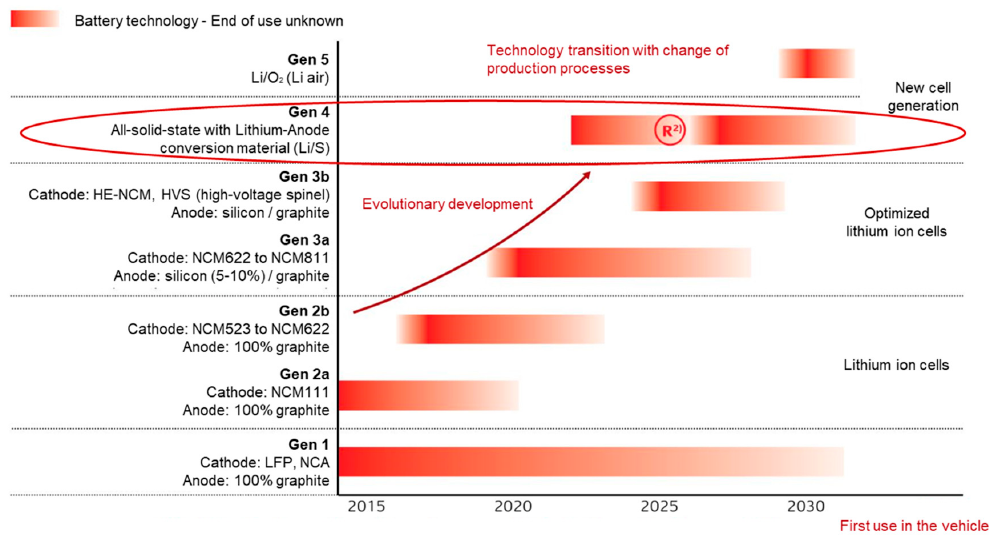
Figure 1. Expected electrochemical technology development for first use in a vehicle; In reference to source: NPE AG2 Batterietechnologie [2].